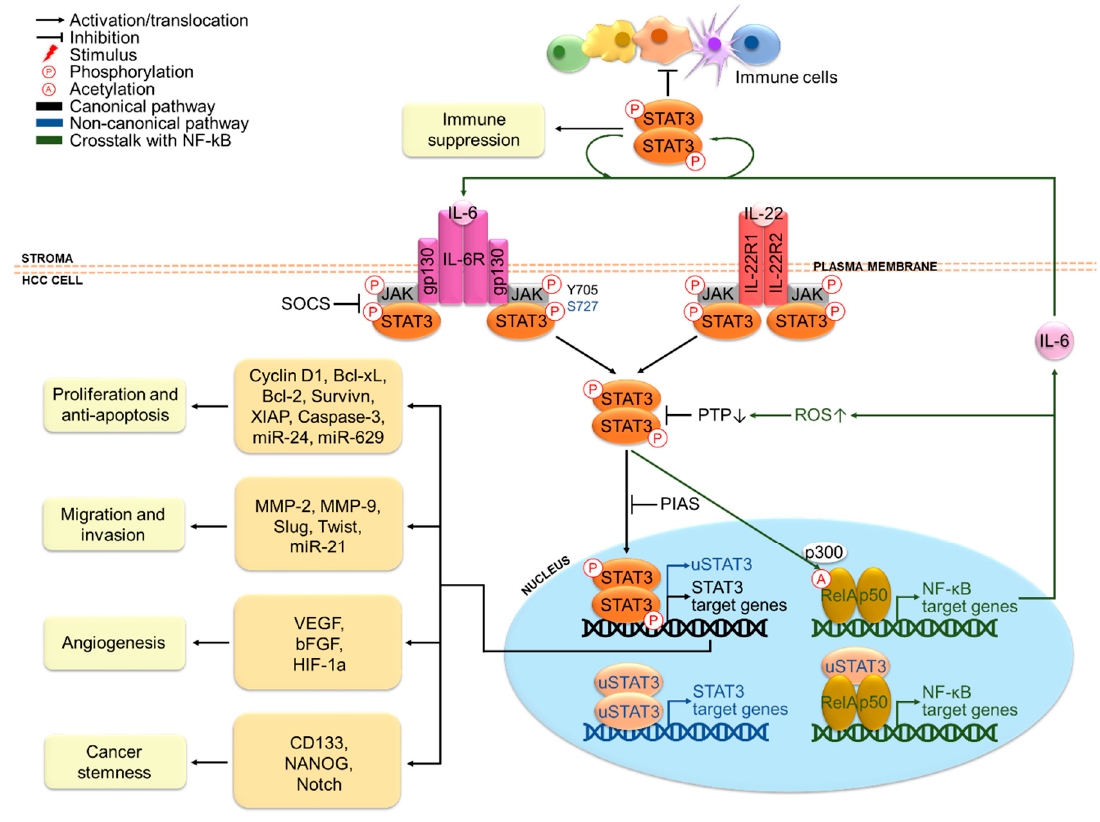
Figure 2. STAT3-mediated oncogenesis in hepatocellular carcinoma (HCC). IL-6 and IL-22 are major stimuli that activate STAT3 signaling in HCC cells. Activated STAT3 promotes HCC cell proliferation, anti-apoptosis, migration, invasion, angiogenesis and stemness properties via transcriptional regulation of target genes, cooperation with NF-kB and epigenetic regulation involving miRNA. A paracrine STAT3 activation loop between tumor and stromal cells also exerts suppressive effects in various immune cells in the HCC tumor microenvironment.